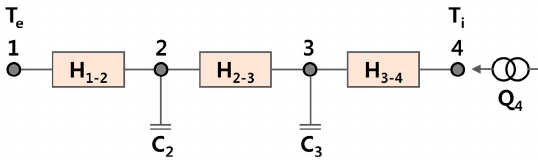
Figure 1. Thermal network model of measured wall comprising three conductances (H 1-2 , H 2-3 , and H 3-4 ) and two capacitances (C 2 and C 3 ).